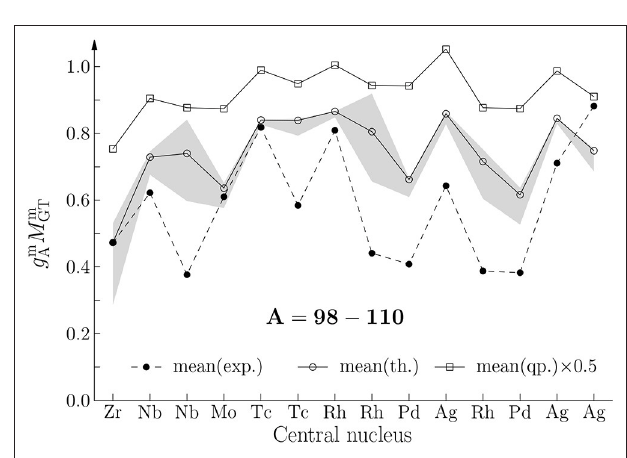
FIGURE 4 | The same as in Figure 3 for the mass range A 62 82. The hatched area describes = − 0.50 0.85 in Table 1 ). = − These ranges have been shown in Figure 7 for easy